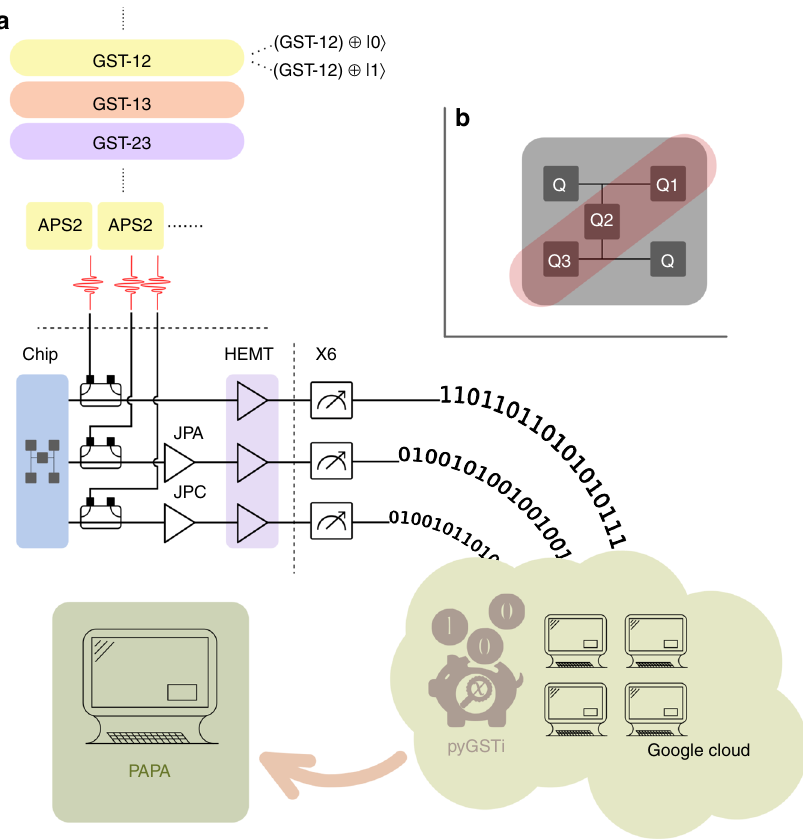
Fig. 5 PAPA experimental data fl ow. a GST experiments are interleaved by pair and spectator qubit state and sent to the BBN Arbitrary Pulse Sequencers (APS2) 59 . Gate instructions are converted to control pulses and sent to the fi ve-qubit device. Demodulated readout signals are fi rst ampli fi ed by HEMTs, JPAs and JPCs then digitized into qubit state information with custom fi rmware running on an X6-1000M digitizer card. This data is then passed to p yGSTi and reconstructed in parallel using Google Cloud Compute services. The three separate reconstructions are then passed to the PAPA algorithm for bootstrapping to three-qubit processes. b A notional diagram of the IBM fi ve-qubit device used in the experiment. The location of the { Q 1, Q 2, Q 3} subset is speci fi ed in red. Lines denote static capacitive coupling through CPW